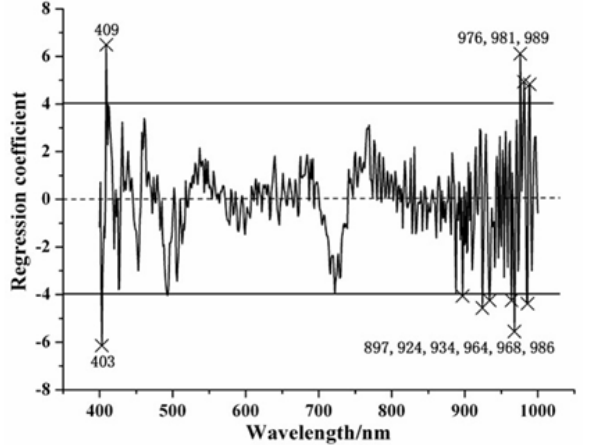
Figure 2. Selected effective wavelengths by regression coefficients.